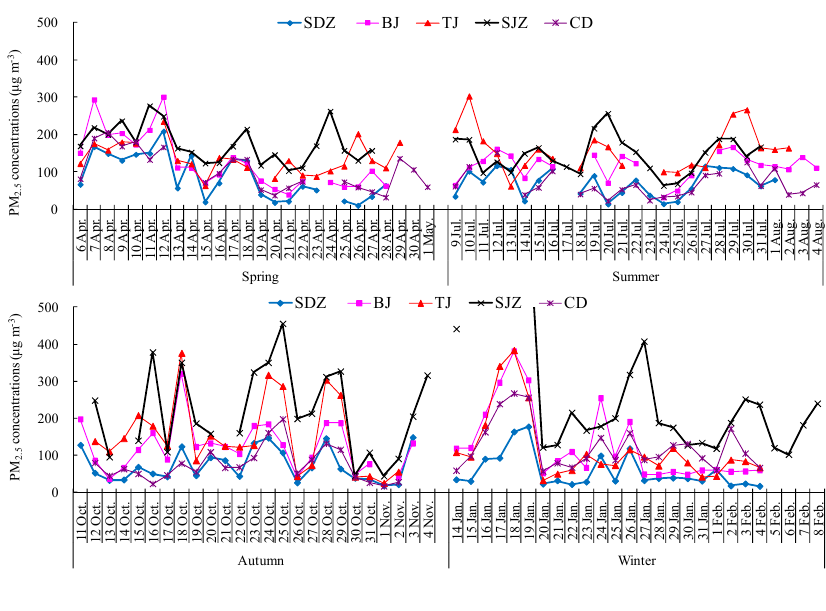
Figure 3. PM 2.5 concentration time series at five sites Fig. 3. PM 2 . 5 concentration time series at the five sites. * 19 January for SJZ was 759.6µgm − 3 *19 Jan. for SJZ was 759.6 μ g m -3 .